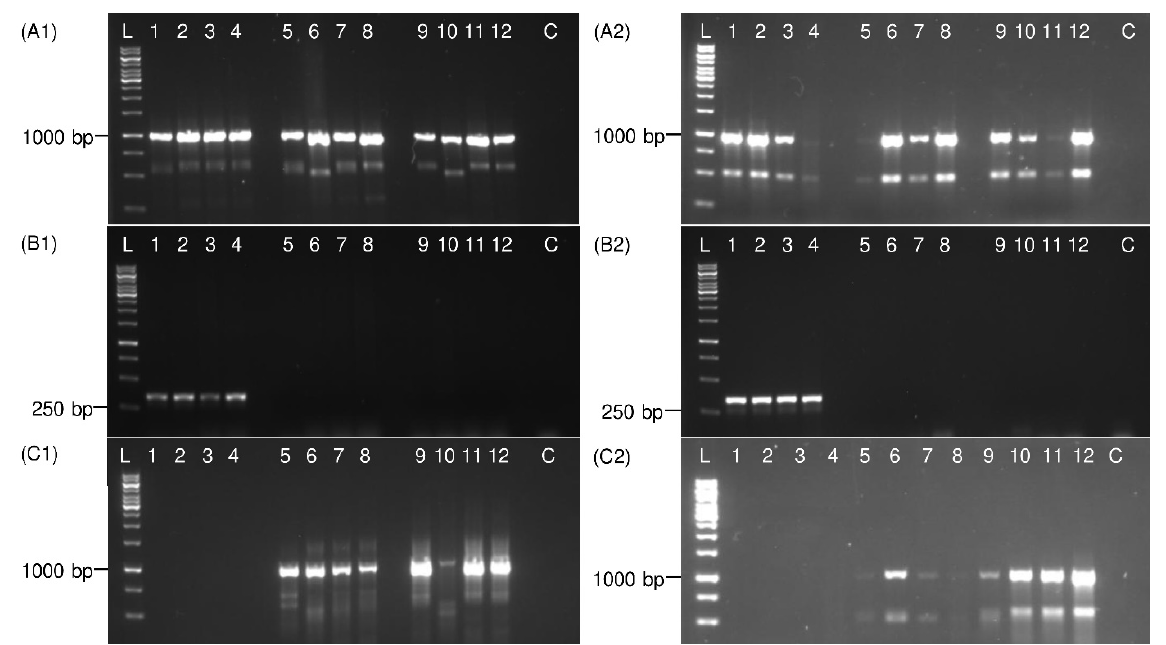
Figure 4. Electrophoretic patterns of PCR products show specific P. leporinus detection. Total DNA was extracted from adult specimens collected from either sweep nets ( A1 , B1 , C1 ) or sticky traps ( A2 , B2 , C2 ) using a blood and tissue kit. In panels ( A1 and A2 ), universal Ron and Calvin primers, in panels ( B1 and B2 ), specific P. leporinus primers and in panels ( C1 and C2 ), universal UEA3 and UEA8 primers were used for PCR. Lanes 1, 2 represent P. leporinus male adult samples; 3, 4 P. leporinus female adult; 5, 6 R. quinquecostatus male adult; 7, 8 R. quinquecostatus female adult; 9, 10 H. obsoletus male adult; 11, 12 H. obsoletus female adult; C: Negative control (water). The sizes of amplicons are shown on the left side and compared with 1 kb ladder (L).